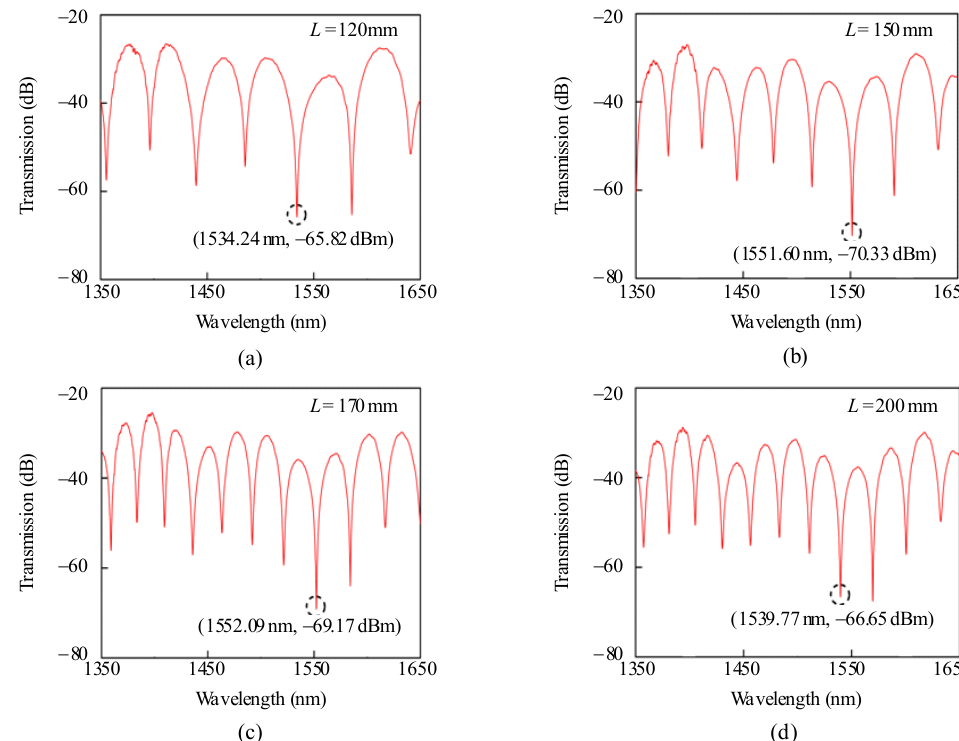
Fig. 2 Transmission spectra of the PMF-based Saganc interferometer with different PMF lengths of (a) 120 mm, (b) 150 mm, (c) 170 mm, and (d) 200 mm at room temperature.